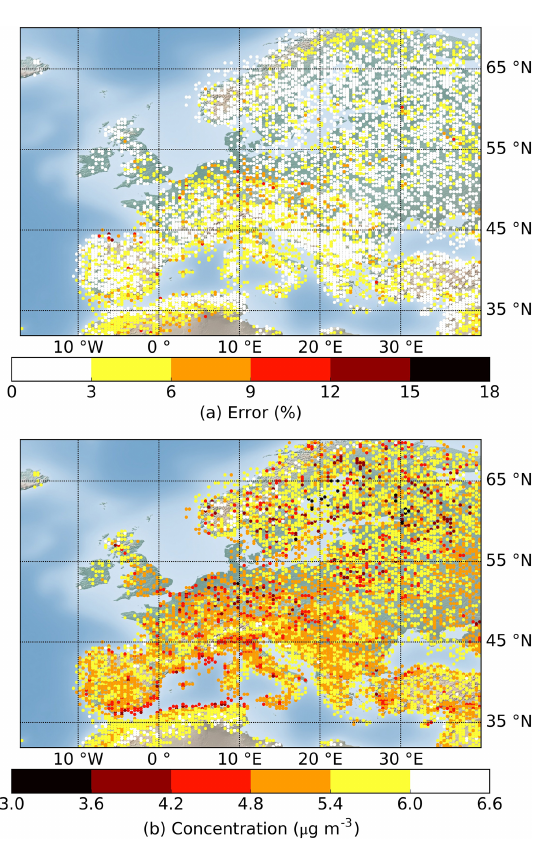
Figure B1. Maps of the (a) error and (b) average SOA concentration of the testing results simulated using the Rdc. mechanism on all (i.e., 12159) testing